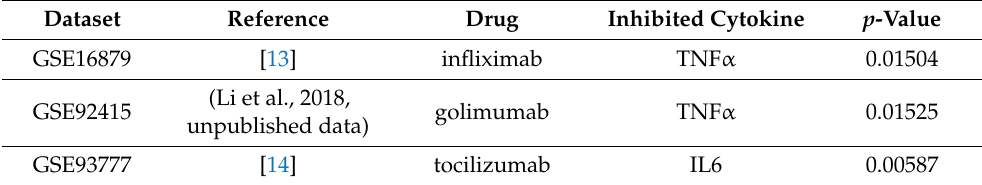
Table 1. Datasets used to investigate the reliability of cytokine–cytokine interactions. Gene expression datasets following cytokine inhibitor treatment were used to determine the significance of the cytokine–cytokine interactions captured by CytokineLink for a subset of cytokines.